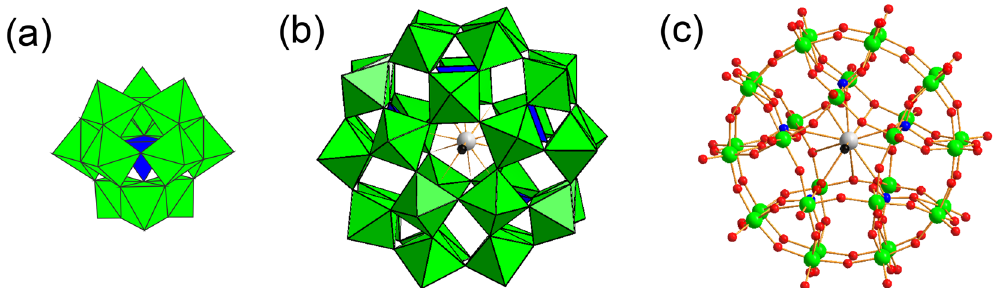
Figure 2. ( a ) Polyhedral representation of Keggin-type phosphotungstate ([PW 12 O 40 ] 3− ). ( b ) Polyhedral and ( c ) ball-and-stick representation of Preyssler-type phosphotungstate, ([P 5 W 30 O 110 M n+ ] (15−n)− ). Blue and green polyhedra represent tetragonal PO 4 and octahedral WO 6 , respectively. Blue, green, grey, red, and black balls represent P, W, encapsulated cation M (Na + , Ca 2+ , Bi 3+ , Y 3+ , or Eu 3+ ), O, and O (H 2 O),